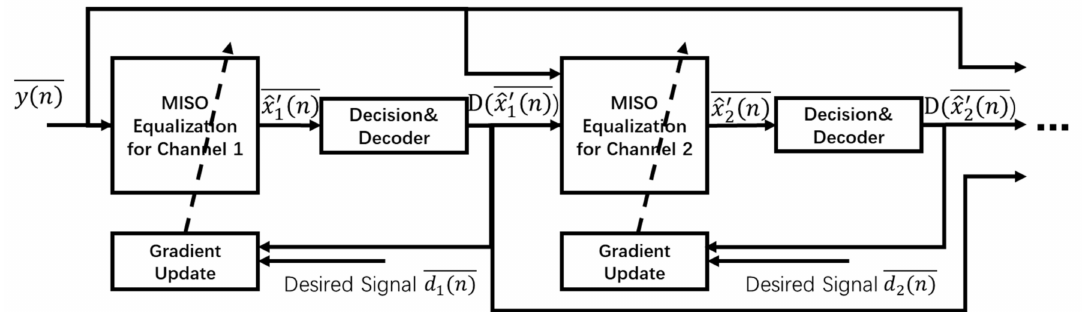
Figure 10. Schematic structures of U-SIC detectors comprising two stages.